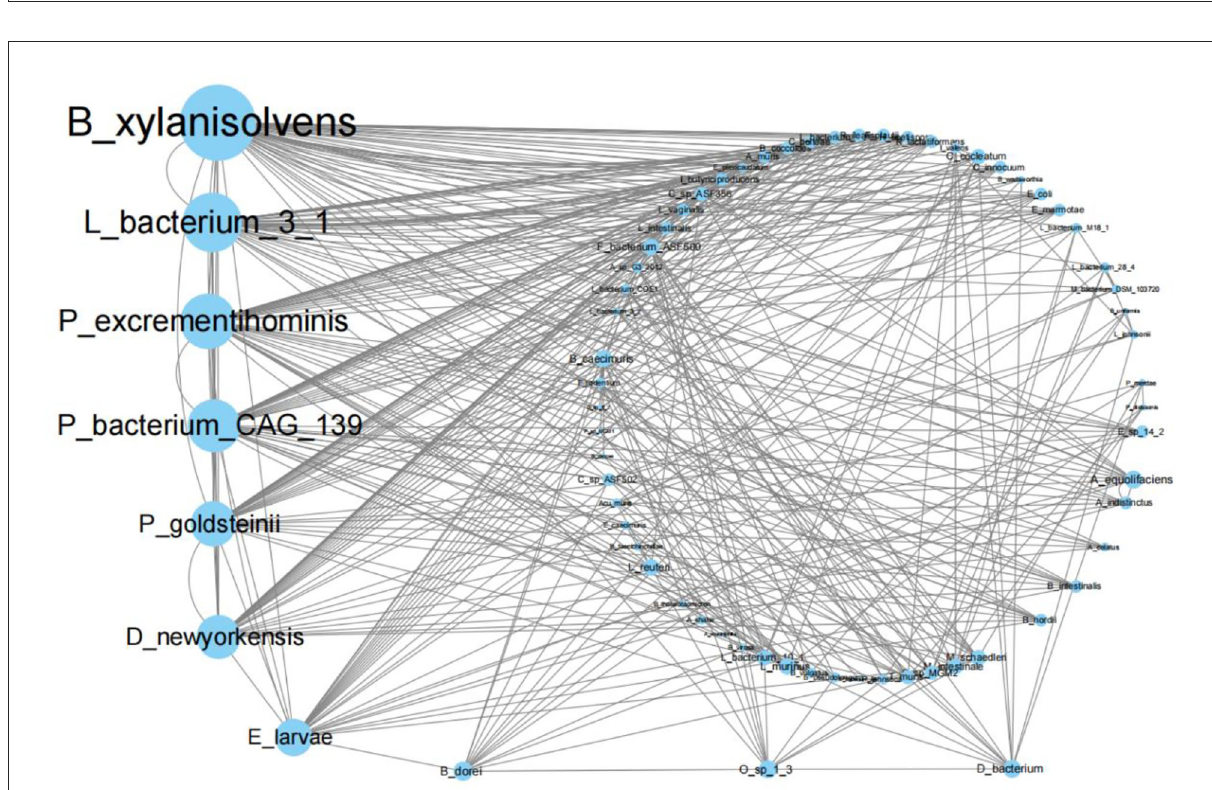
FIGURE4 Granger causality network for mouse gut microorganisms treated by the Sijunzi Decoction with p < 10 − 4 .